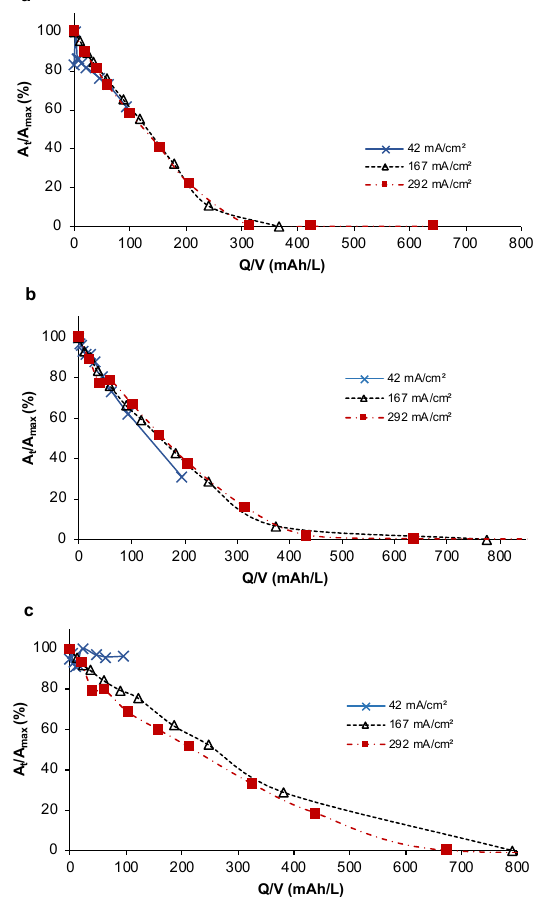
Figure 1. Degradation of diclofenac (DCF) expressed as %-variation of the peak area (A t / A max ) of the respective EIC over the applied charge per volume (Q / V) in deionized water ( a ), drinking water ( b ), and wastewater e ffl uent ( c ), at three di ff erent current densities (j = 42, 167 and 292 mA / cm 2 ). DCF reacts with both ozone and hydroxyl radicals, as both can be formed by the BDD electrode used in this study [31]. The reaction constants for the oxidation of DCF with non-selective hydroxyl − 1 − 1 radicals (k OH 7.5 ± 1.5 × 10 9 M s ) are higher than those with ozone (k O3 around 1 × 10 6 M As the compound is showing a good, selective reactivity towards ozone [41], it is possible to monitor the matrix-driven depletion of oxidants through the measurement of dissolved ozone in the di ff erent water matrices. The maximum ozone values in drinking water were 0.068 mg / L for 42 mA / cm 2 , 0.354 mg / L for 167 mA / cm 2 , and 1.07 mg / L for 292 mA / cm 2 . In wastewater e ffl uent, the highest values were significantly lower, resulting in 0.022 mg / L at 42 mA / cm 2 , 0.185 mg / L at 167 mA / cm 2 and 0.553 mg / L at 292 mA / cm 2